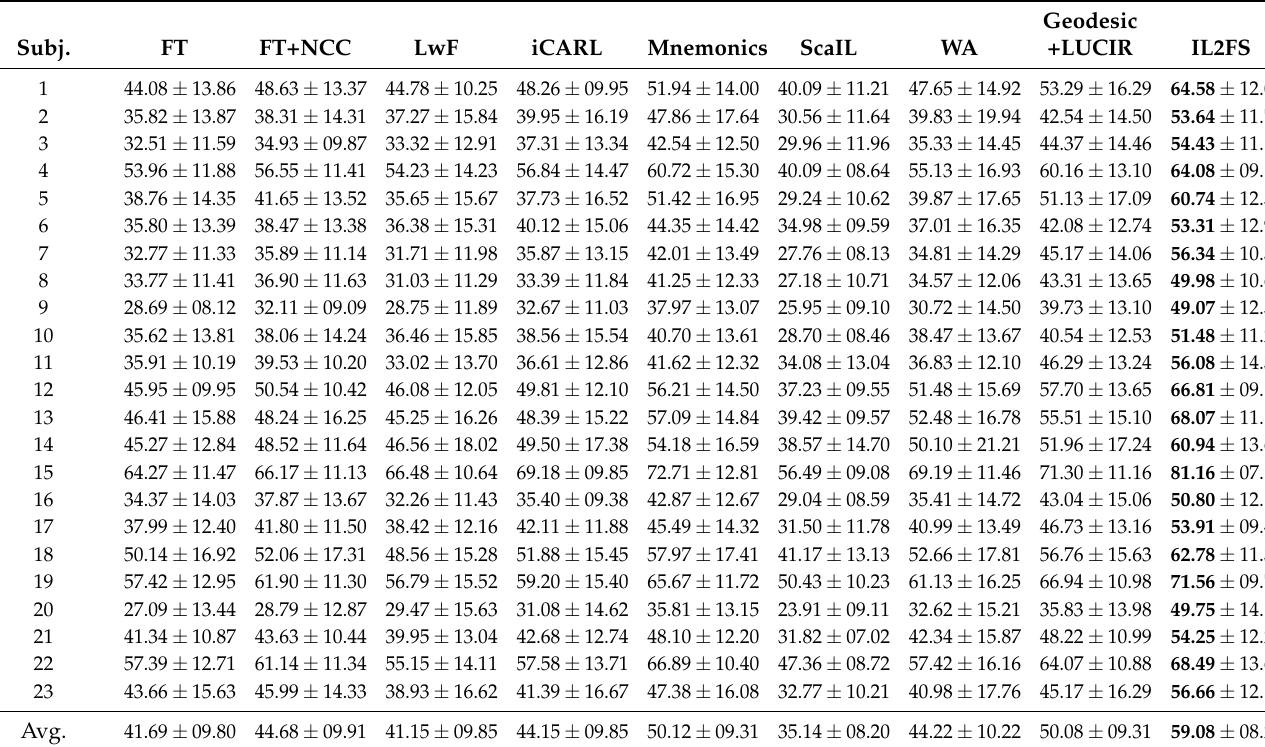
Table 3. Accuracy and standard deviation for CIL methods on the DREAMER dataset using approxi- mately 1% of the training size. The best results are in bold.